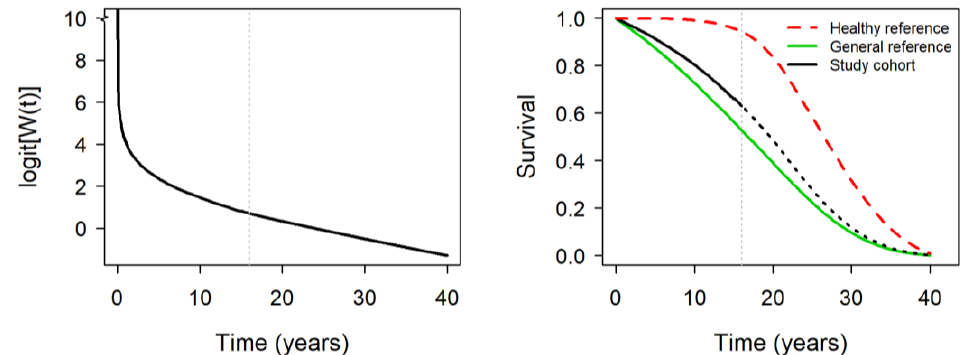
Figure 1. Extrapolated logit [ W ( t )] curve and survival functions for a study cohort and matched reference populations.